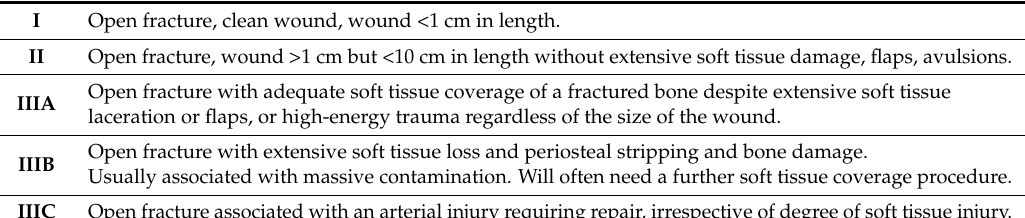
Table 2. Gustilo–Anderson Classification of open